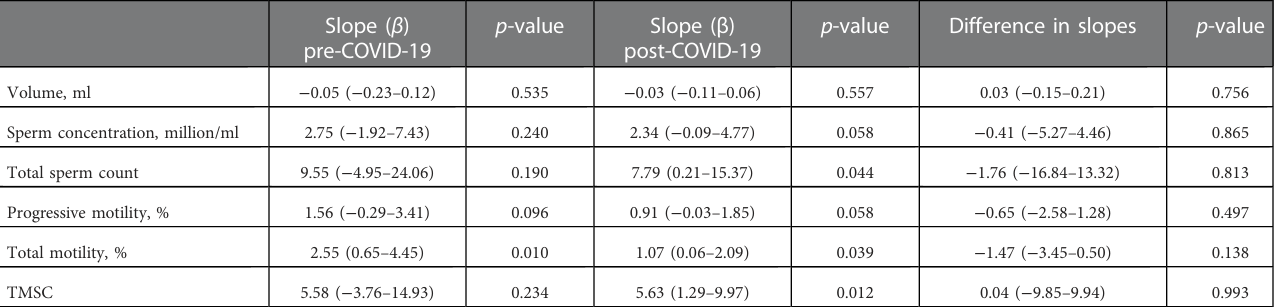
TABLE 2 Estimates and associated 95% con fi dence intervals (CI) for the slope β . The models are adjusted for age, days of sexual abstinence, frequency of ejaculations and presence of fever.